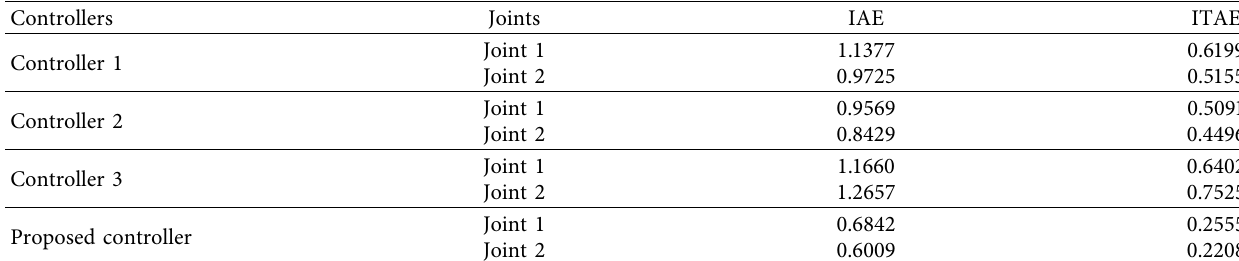
Figure 13: Zoomed position tracking errors under four controllers. Table 1: Comparison of control